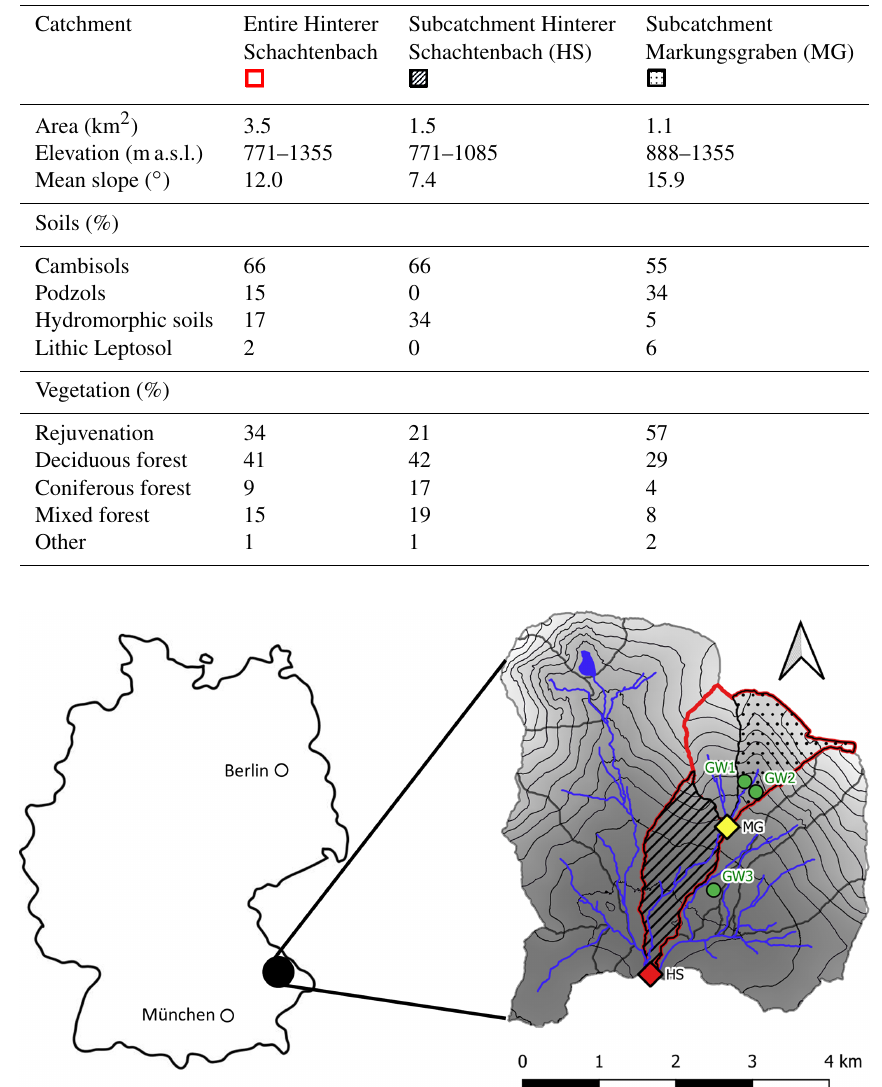
plete sampling period were taken from the database of the Bavarian State Office for Environment